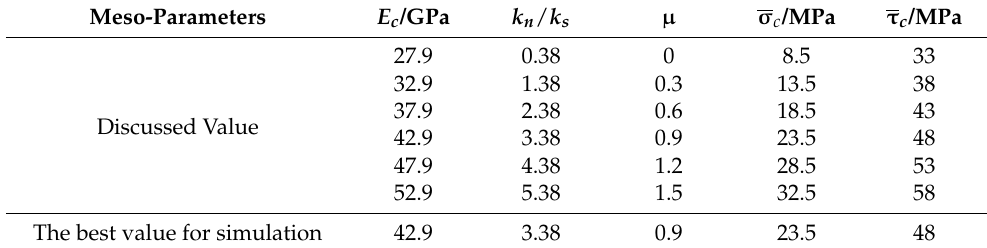
Table 4. Mesoscopic parameter values of C40 concrete.